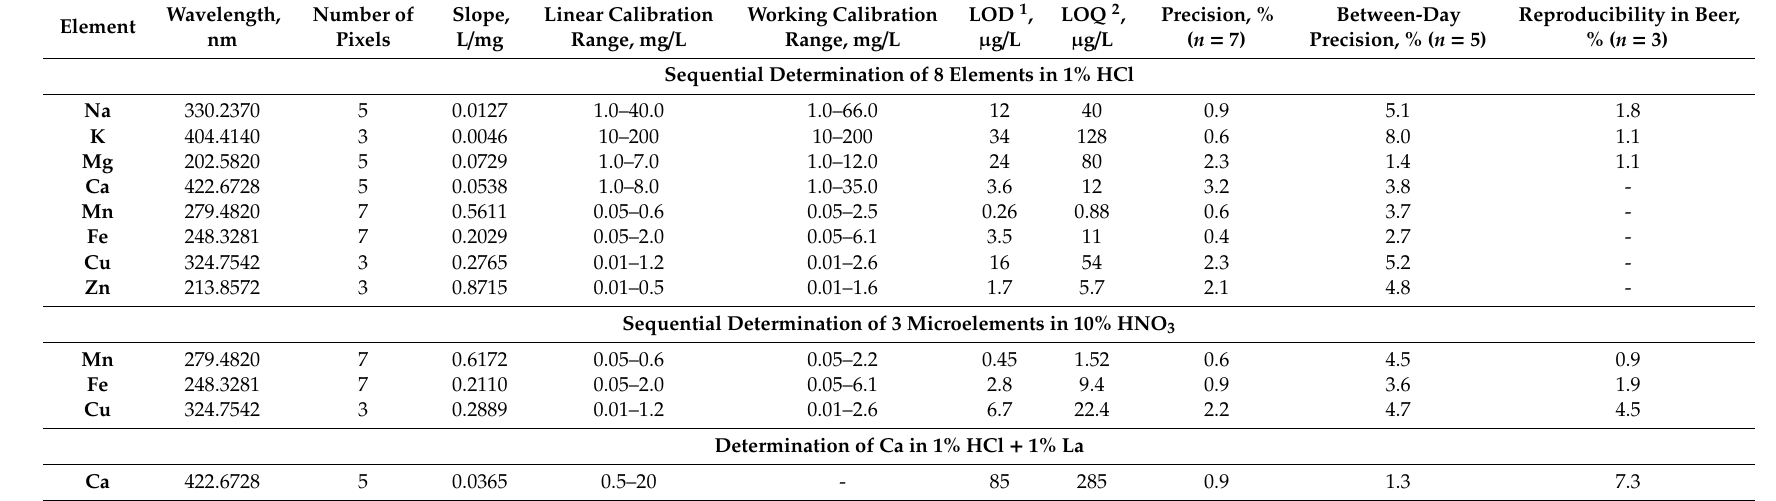
Table 1. Instrumental parameters and analytical characteristics of methods for determination of target macro- and microelements by high-resolution continuum source flame atomic absorption spectrometry (HR CS FAAS). Sequential determination of Na, K, and Mg in beer was performed for samples diluted with 1% HCl; sequential determination of Mn, Fe, and Cu was performed in samples of beer digested with HNO 3 + H 2 O 2